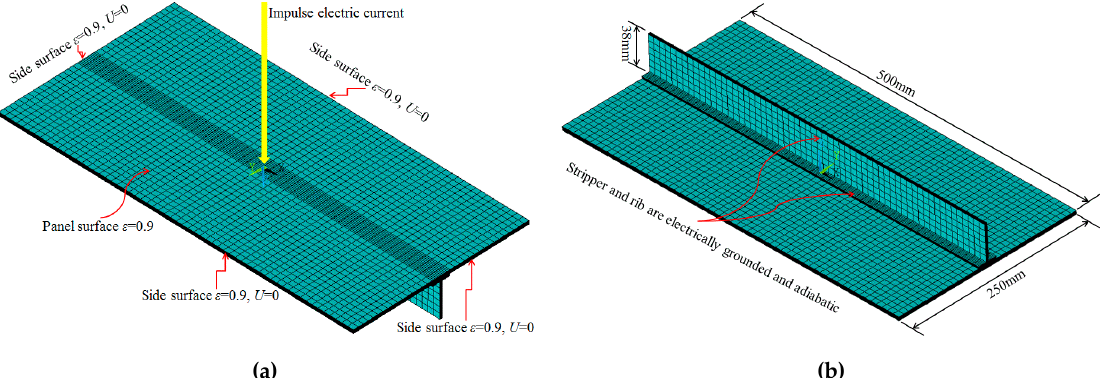
Figure 2. Finite element model and boundary conditions of the composite reinforced panel. ( a ) Boundary conditions in benchmark skin; ( b ) boundary conditions in the T stripper.